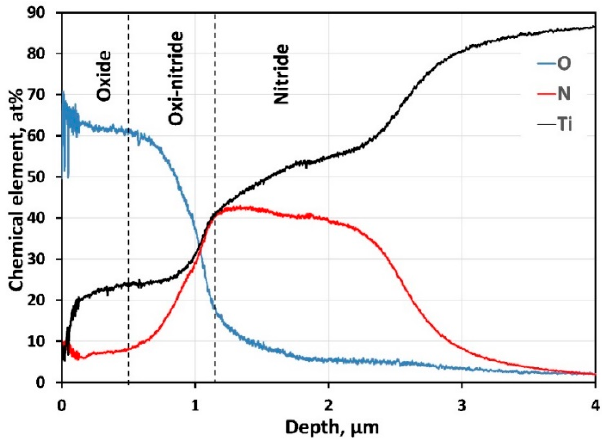
Figure 5. GDOES composition profile of the chemical elements in-depth of the coating.